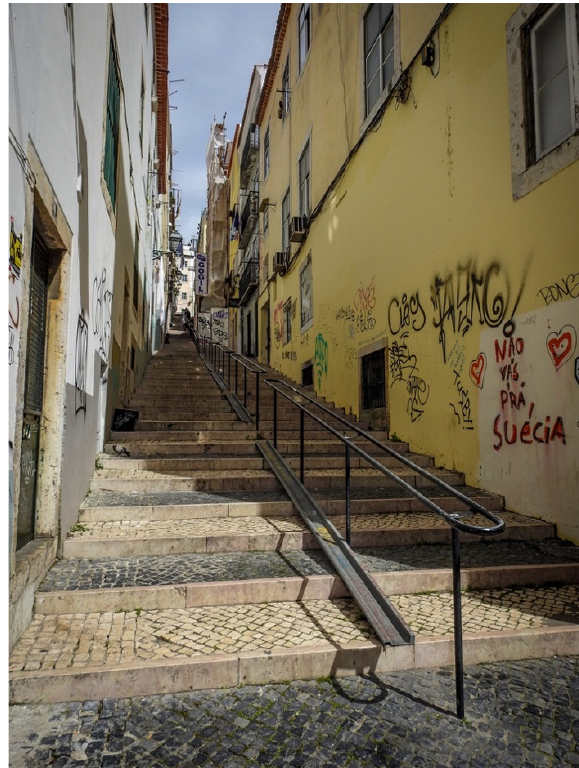
Figure 14. Photograph extracted using the keyword “Graffiti” in the city of Lisbon (Flickr, 2018e), which true location was identified 713m away from the post